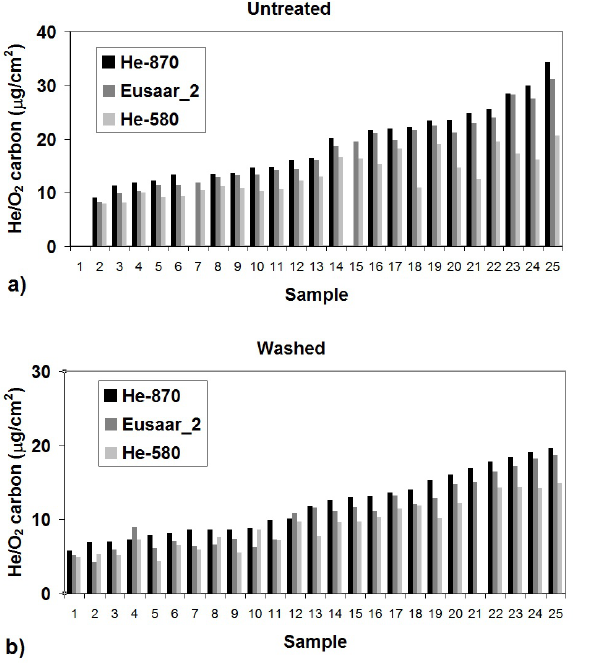
Fig. 7. He/O 2 carbon in untreated (a) and washed (b) samples